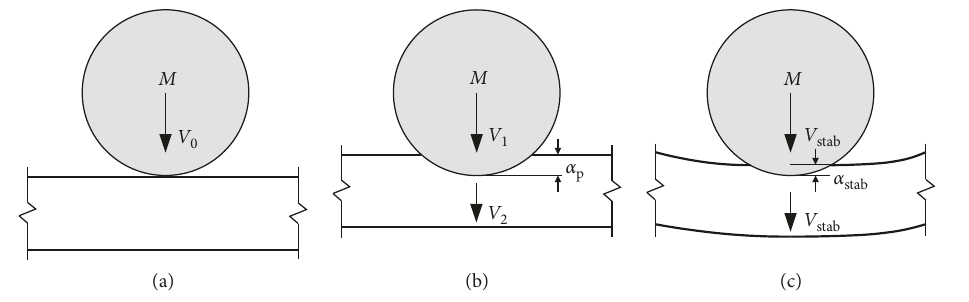
Figure 2: Collision process during the first impact impulse. (a) t � 0. (b) t � t